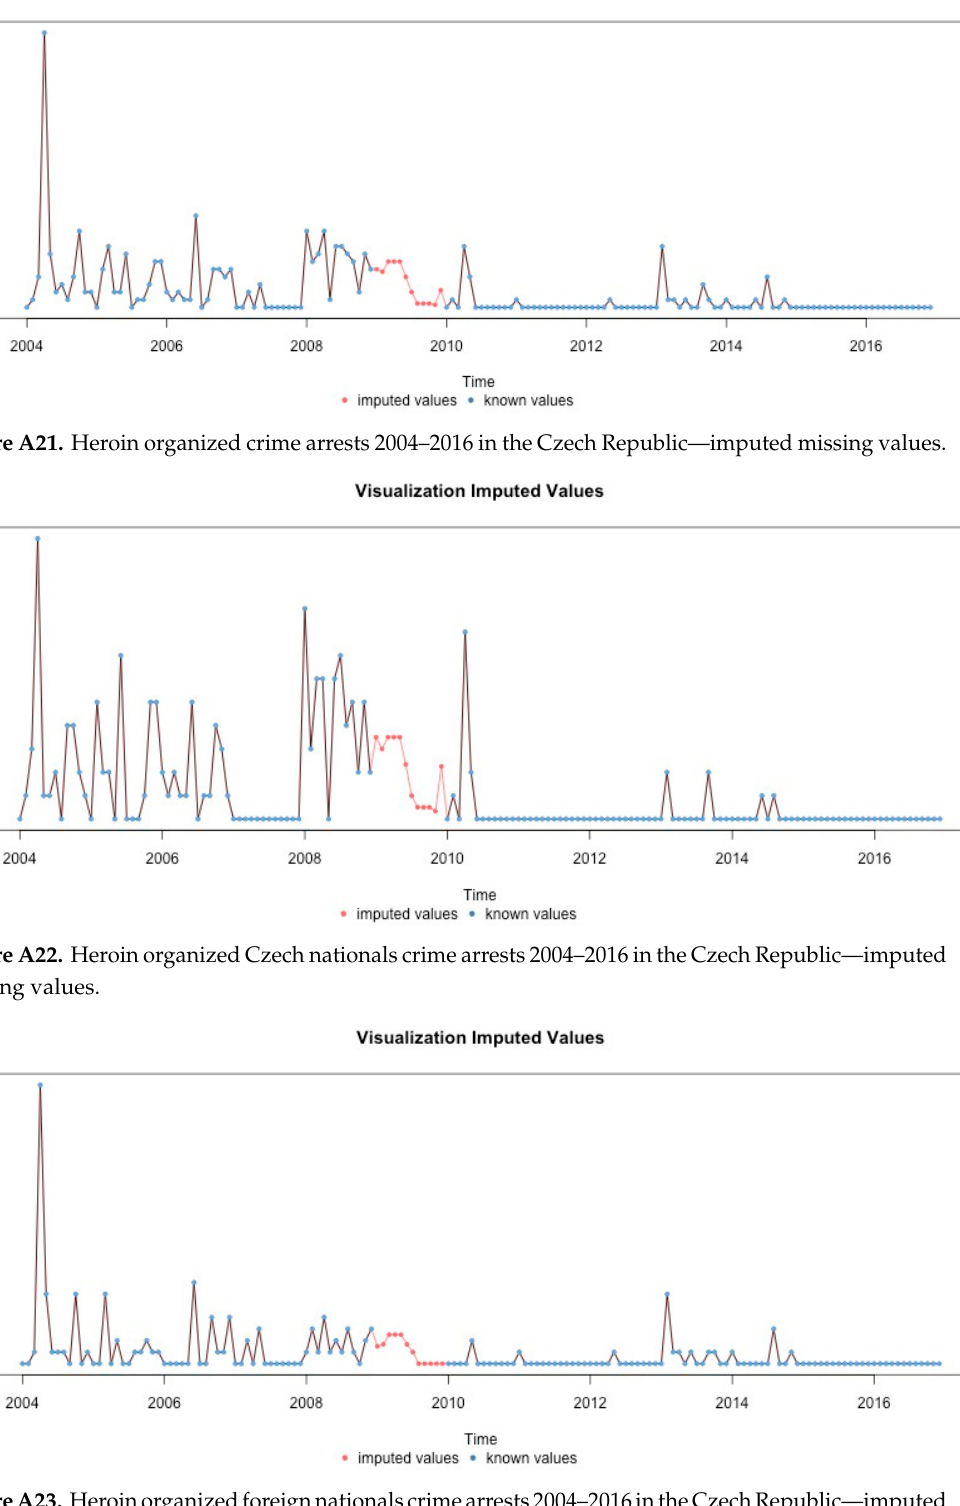
Figure A24. Heroin organized Vietnamese nationals crime arrests 2004–2016 in the Czech Republic – imputed missing values .